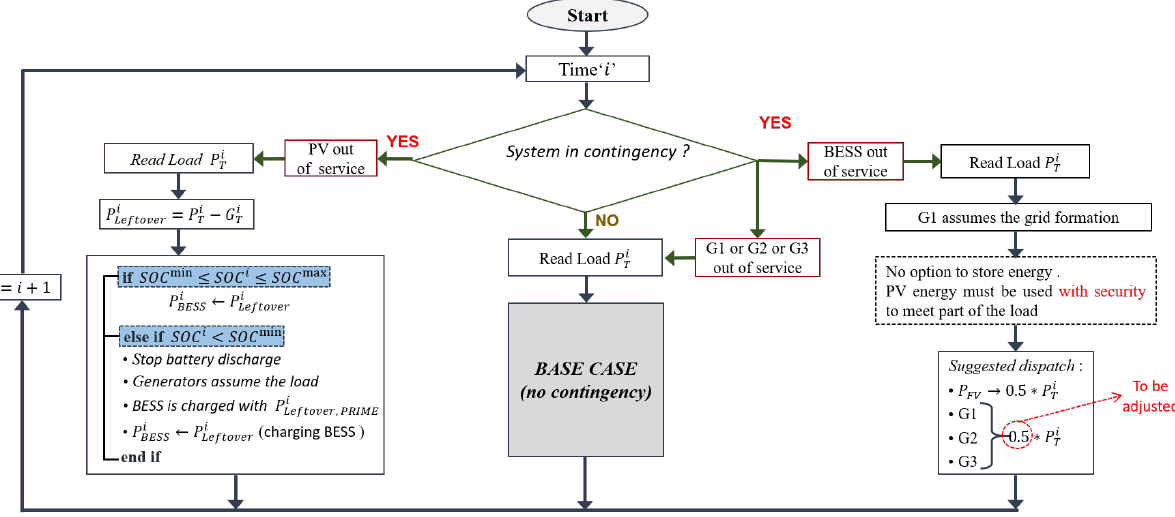
Figure 6. Discretized modeling of the ASC- µ Grid real time operation in off-grid mode—case with